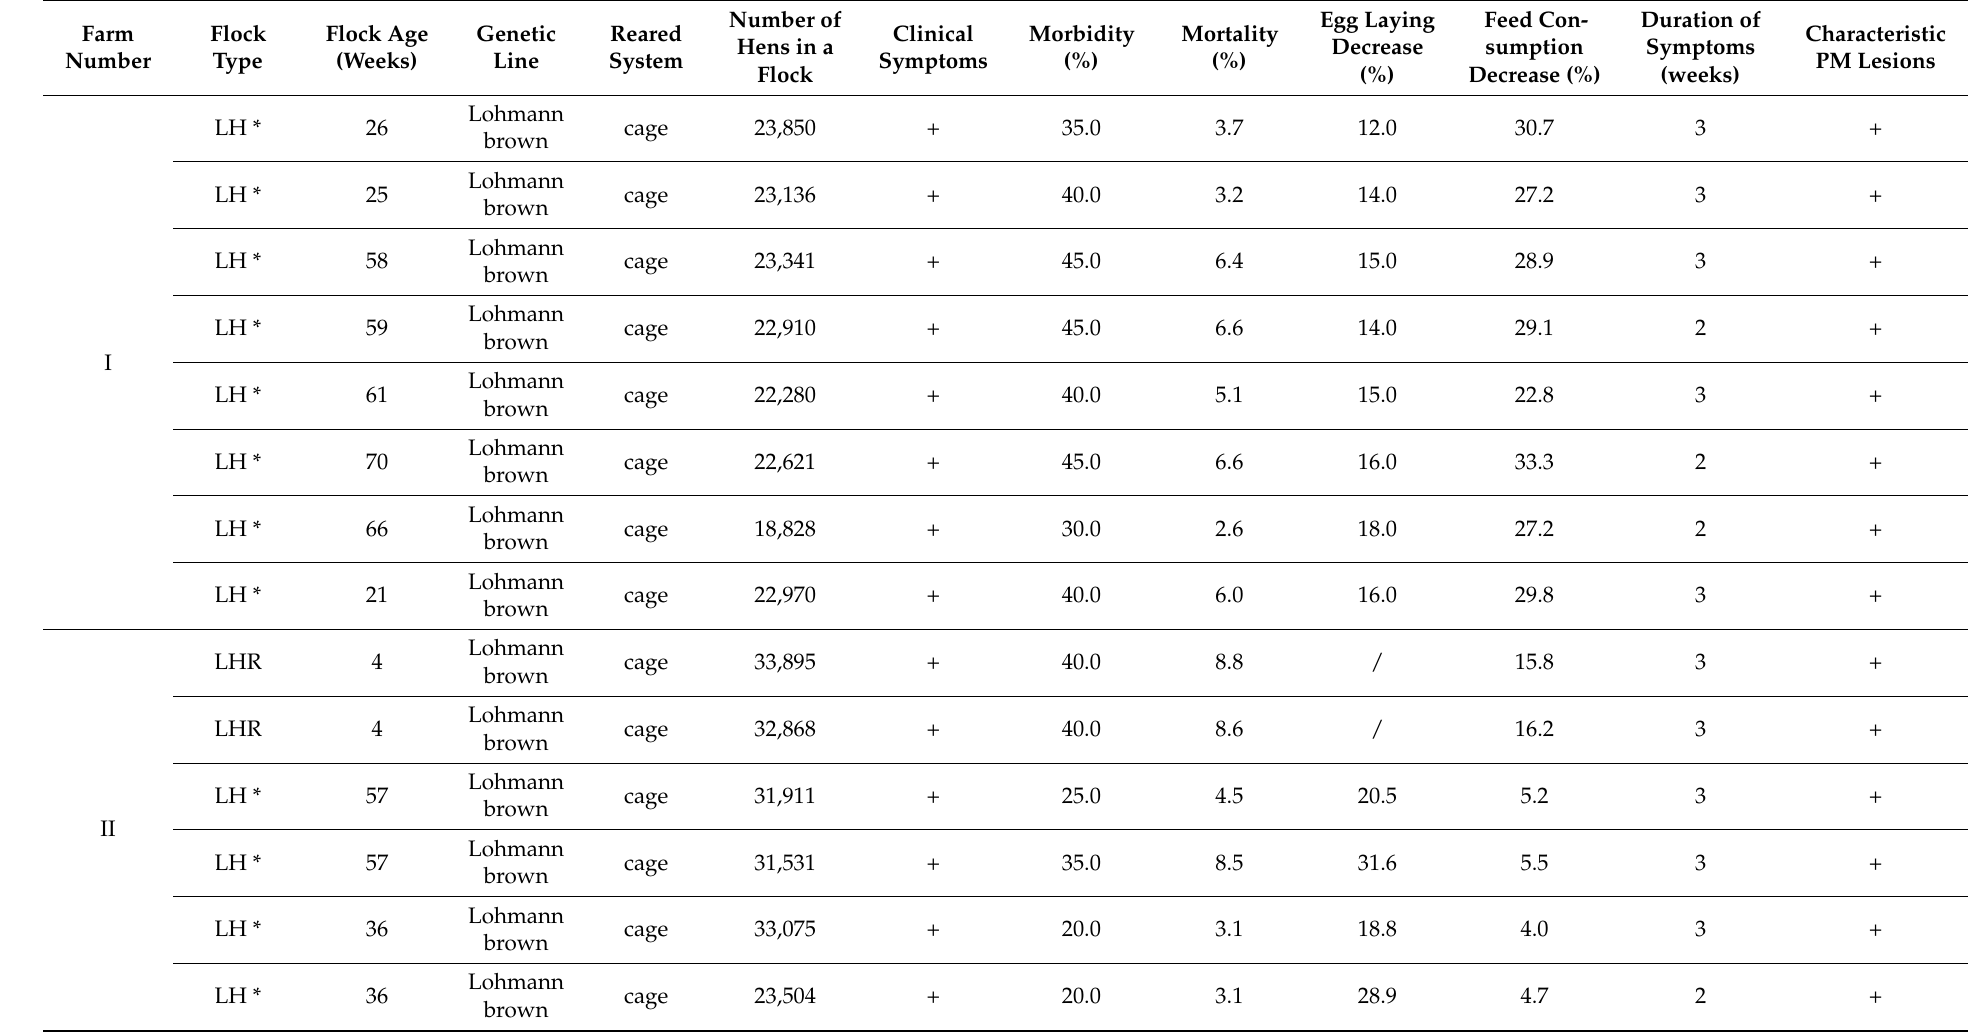
Table 1. Data on diseased chicken flocks from all farms and data on clinical